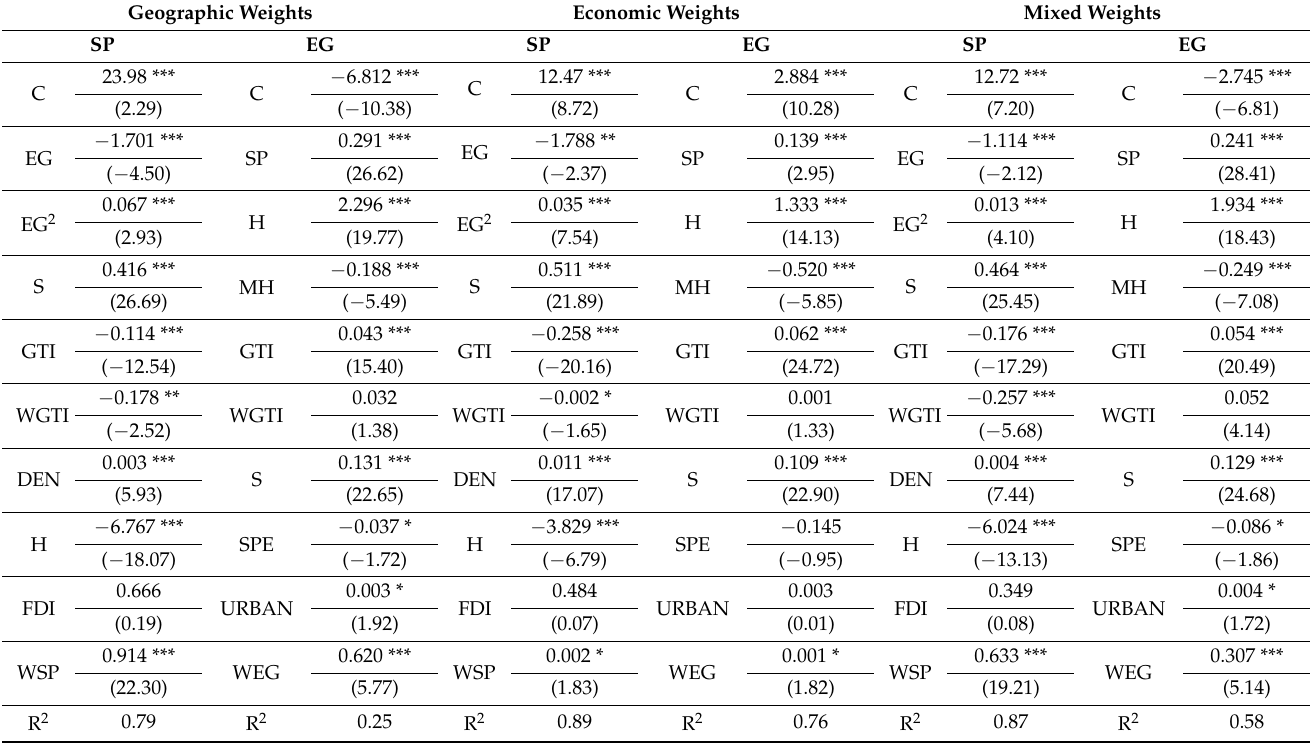
Table 4. Effects of GTI on SP and